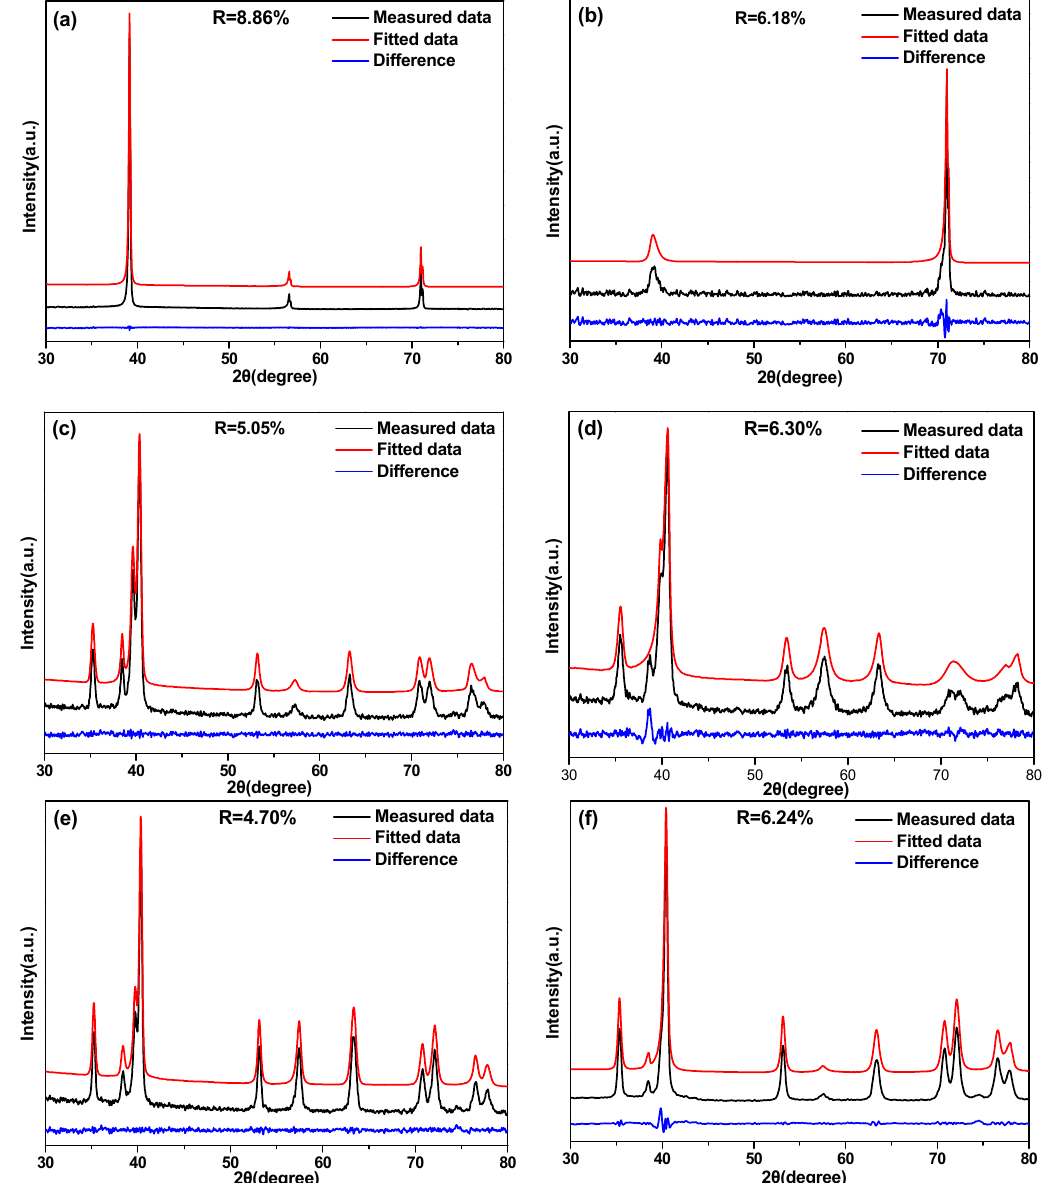
Figure 9. The profile fitting results of the XRD patterns of the Ti–3.5Al–5Mo–4V alloy solution-treated at ( a , c , e ) 850 °C and ( b , d , f ) 1050 °C, then isothermally aging-treated at 500 °C for ( a , b ) 2 min, ( c , d ) 4 h, and ( e , f ) 32 h.